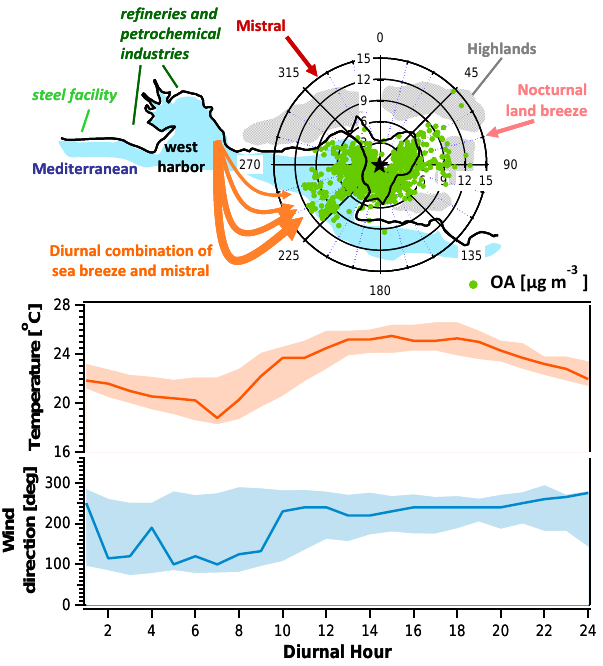
Fig.1: Marseille’s topography, wind circulation and general conditions encountered during the measurement period. The map shows the sampling site ( black star ) in the downtown park “Cinq Avenues”, with respect to the major industries. The wind rose shows OA concentrations measured by the AMS as a function of wind direction. Lower frames show the diurnal profiles for the temperature and wind directions. Solid lines denote median profiles and dashed areas denote P25-P75 ranges.